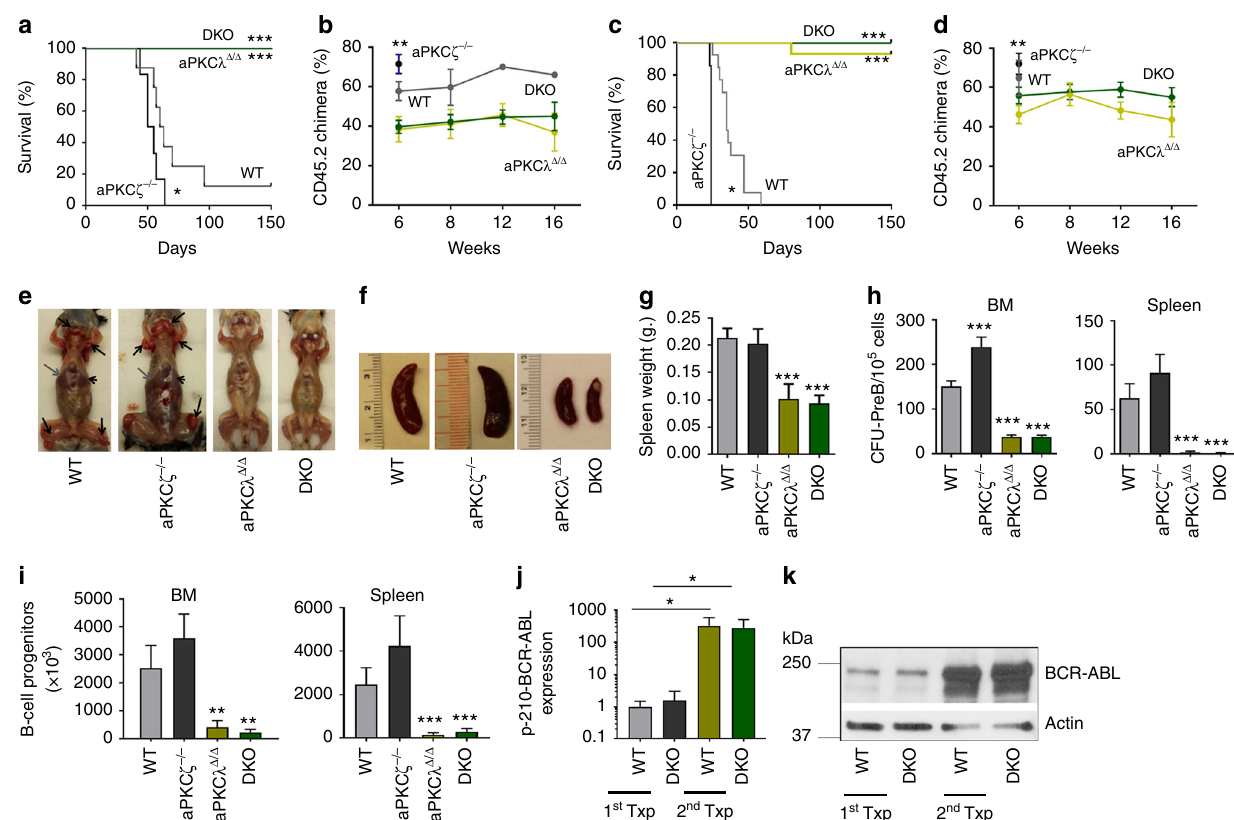
Fig. 2 De fi ciency of aPKC λ , but not aPKC ζ , abrogates the development of B-ALL. a Kaplan – Meier survival analyses of competitively transplanted